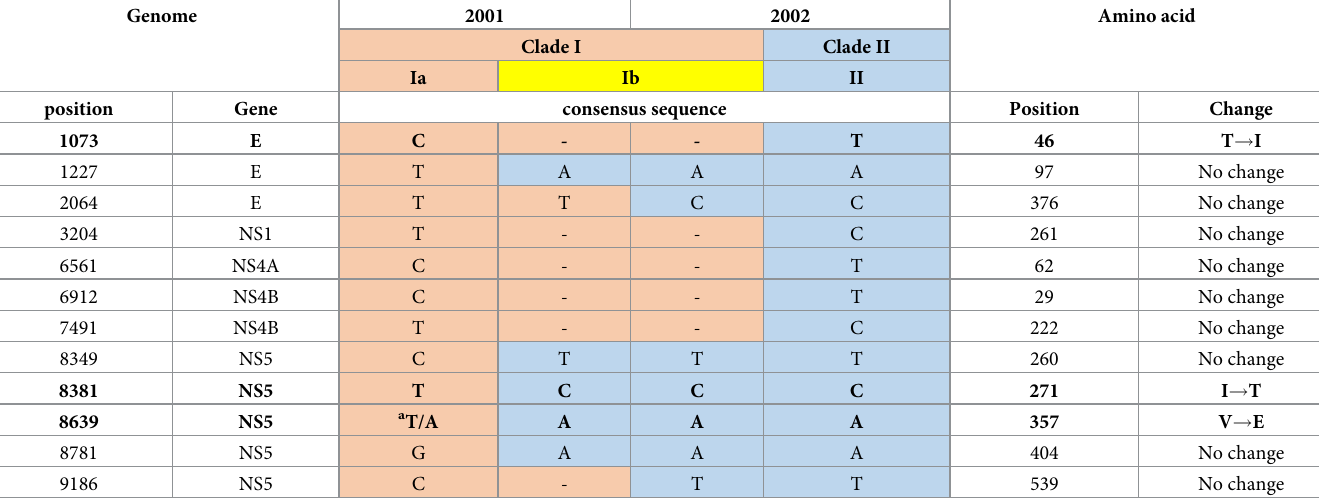
Nucleotide changes among three groups of DENV-2 isolates collected at different time points from September 2001 to March 2003, in Kaohsiung/Pingtung, Taiwan. Three non-synonymous mutations were identified: E-46, NS5-271, and NS5-375. a Four or three of seven clade Ia viruses had T or A at nt-8639 (NS5-357) position,